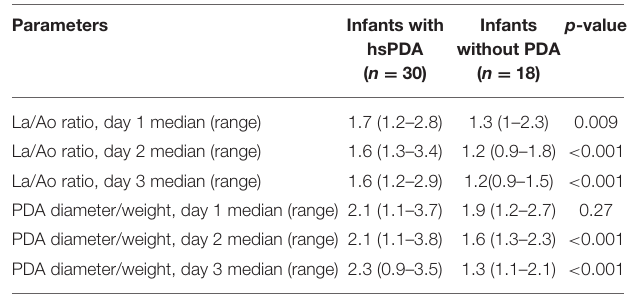
TABLE 4 | Mortality and co-morbidities between study groups. TABLE 5 | Echocardiography indices of the study